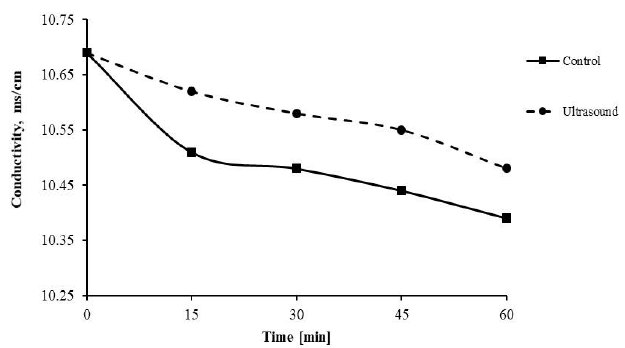
Figure 5. Comparison of conductivity variation with and without sonication.